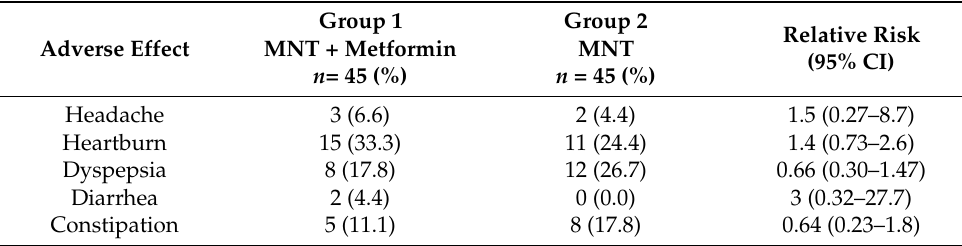
Table 8. Adverse effects associated with the use of metformin in Mexican women who received intensive MNT plus metformin versus only intensive